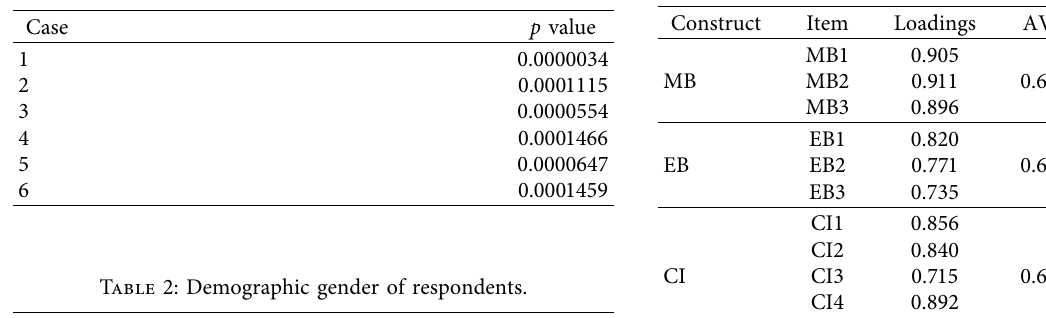
Table 1: Mahalonobis outlier analysis.